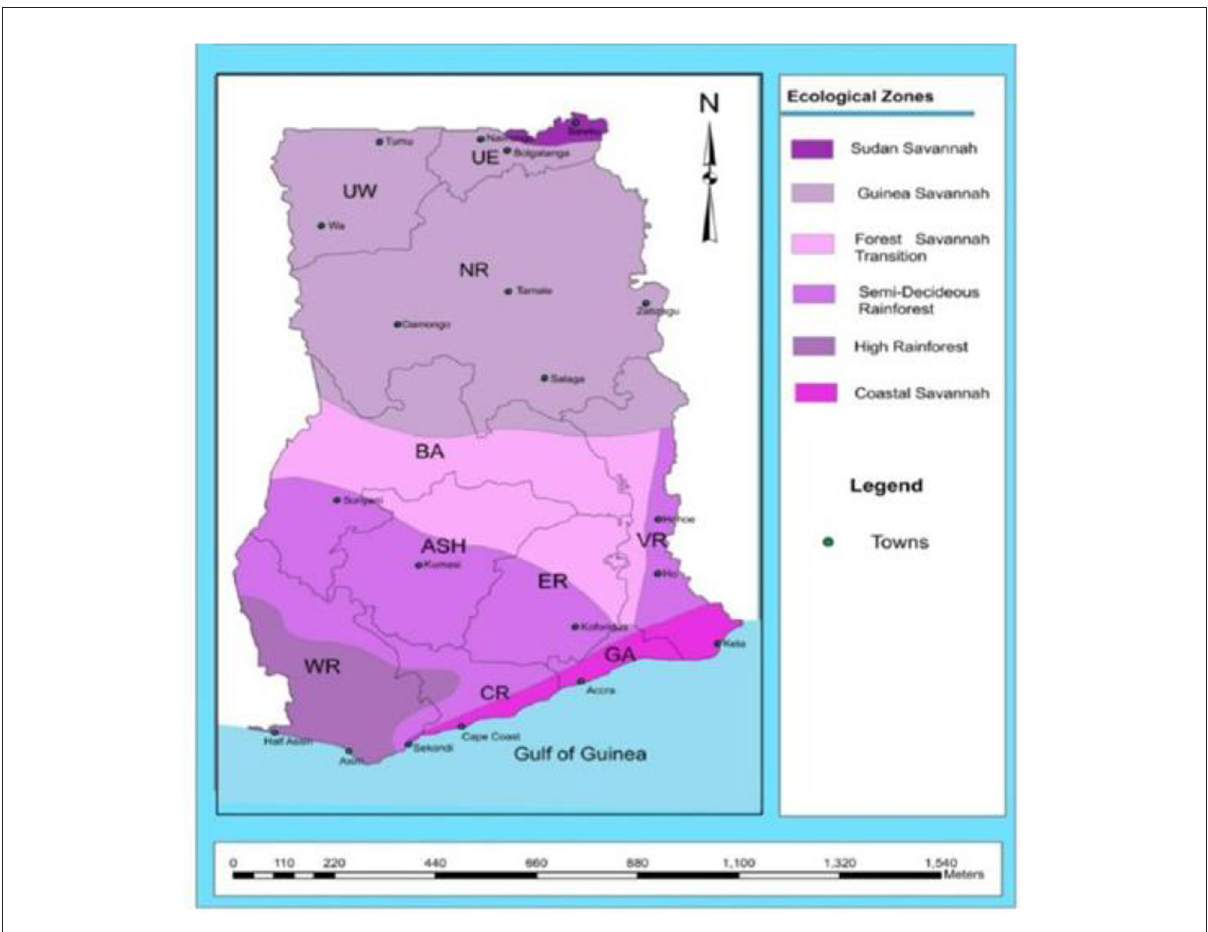
FIGURE1 Ecological zones of Ghana [source: Issaka et al.